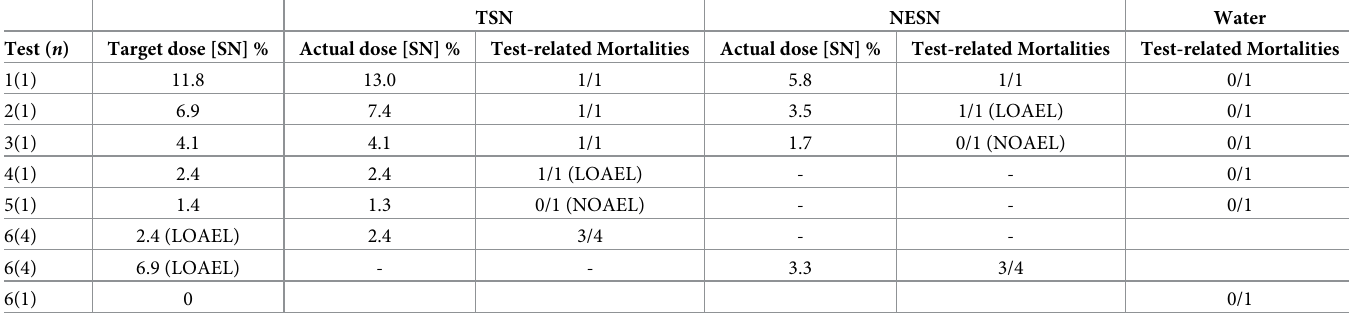
Table 1. Test-related mortalities among European starlings gavaged (i.e., dosed) with technical sodium nitrite (TSN), nanoencapsulated sodium nitrite (NESN), or demineralized water (untreated control) in Experiment 1. TSN NESN Water